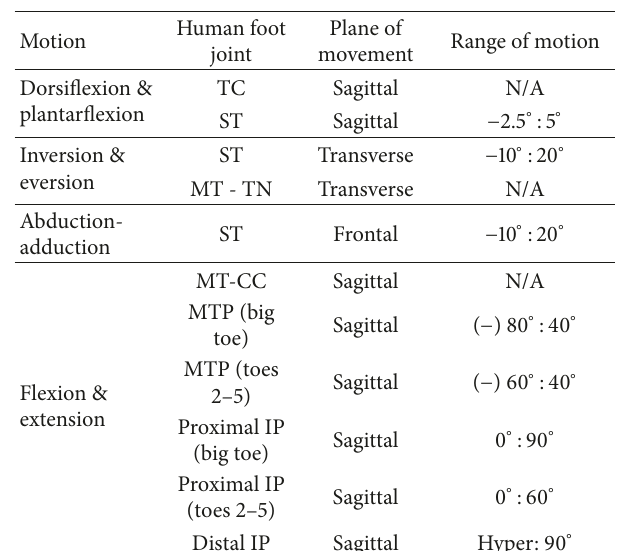
Table 1: Ranges of motions of human foot